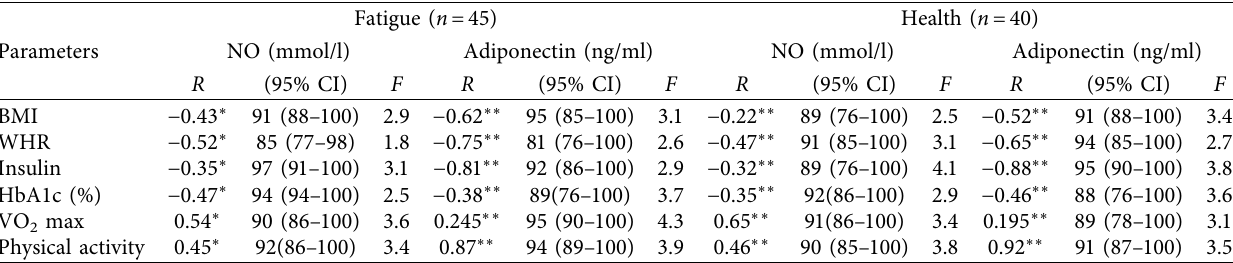
Table 3: Association between nitric oxide (NO), adiponectin, adiposity, diabetic markers, and physical activity in fatigued older adults ( n �